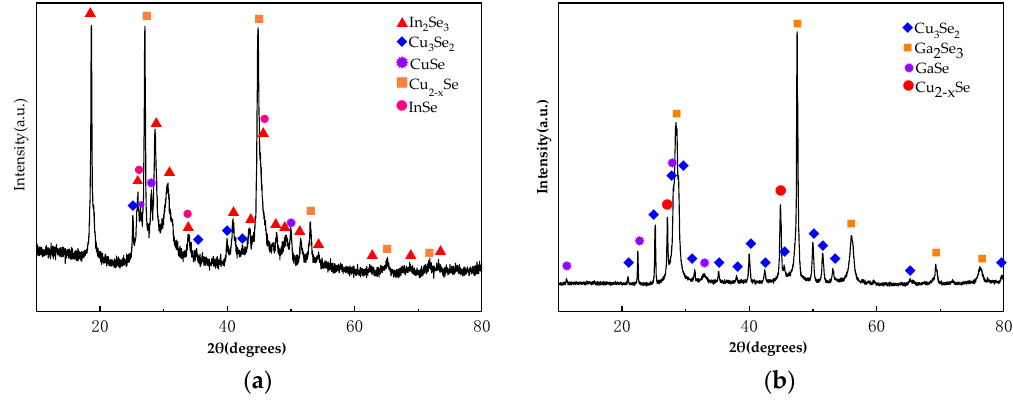
Figure 2. The X-ray diffraction patterns of the Cu 2 Se and In 2 Se 3 mixture powders ( a ); and the Cu 2 Se and Ga 2 Se 3 mixture powders ( b ) after 1 h of milling.